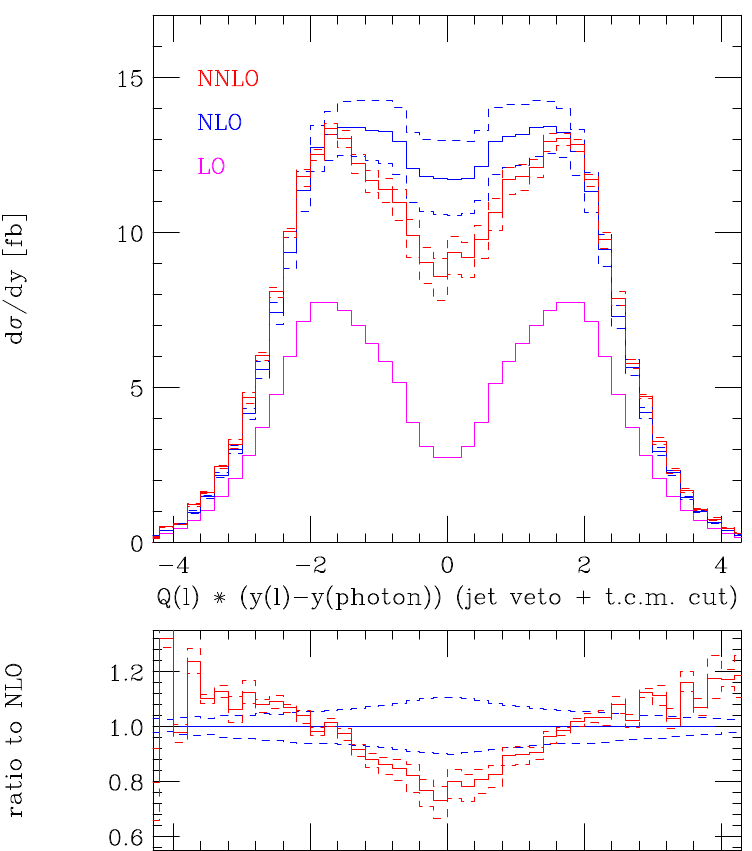
Figure 8 . Signed rapidity difference between the lepton and the photon at 13 TeV, after additional cuts to veto jets and require M ( ‘γE miss ) > 150 GeV. The NNLO and NLO histograms display the T T error estimates, obtained via a 9-point scale variation, and the lower panel displays the ratio of the NLO and NNLO predictions to the central NLO